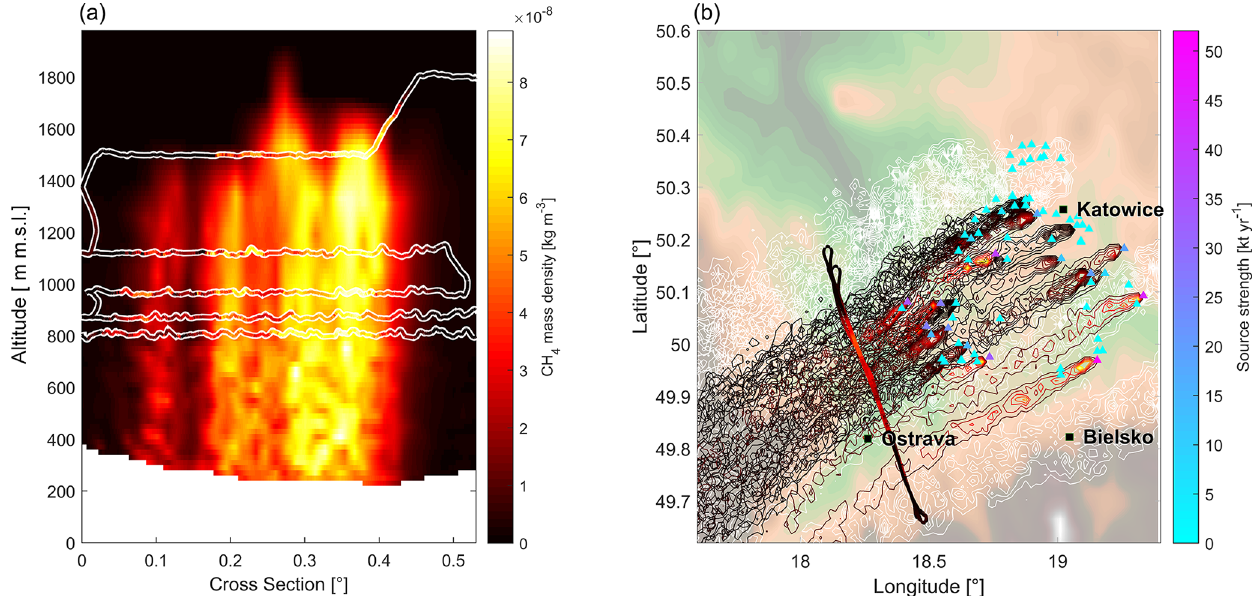
Figure 10. (a) Interpolated cross section of the model output along the downwind wall including scattered in situ observations of CH 4 for the afternoon flight on 6 June 2018. The color bar also applies to the isolines on the right. (b) Top-down view of the model output and the downwind wall observations ρ at 750ma . g . l . with underlaid topography. Gray isolines correspond to non-fuel-exploitation emissions. Triangles mark simulated emitters with colors corresponding to the optimized source strengths. Both panels show a snapshot of the model output at one fixed time chosen as the center time of the downwind wall